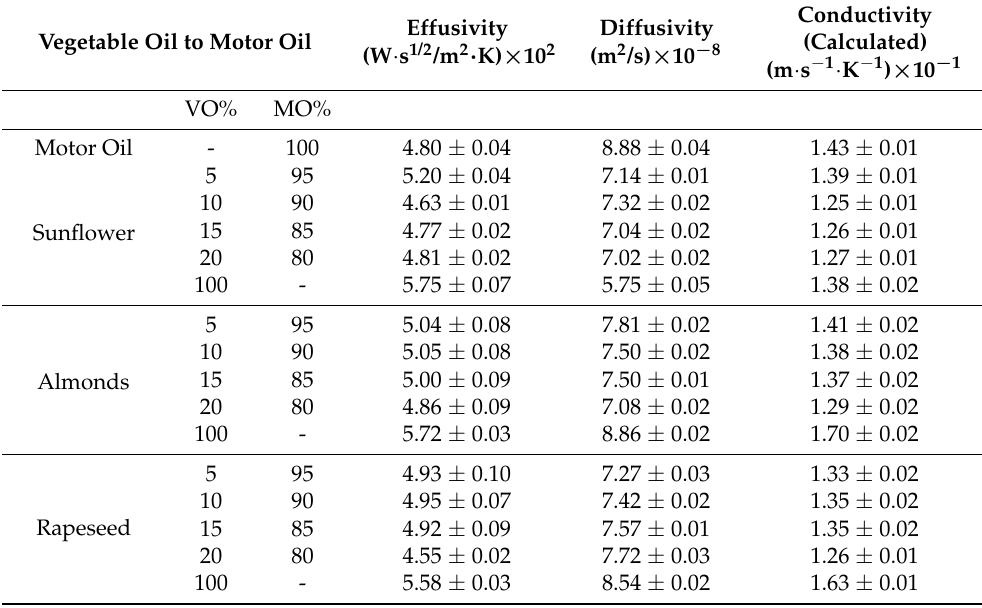
Table 2. Obtained values for thermal effusivity and thermal diffusivity.